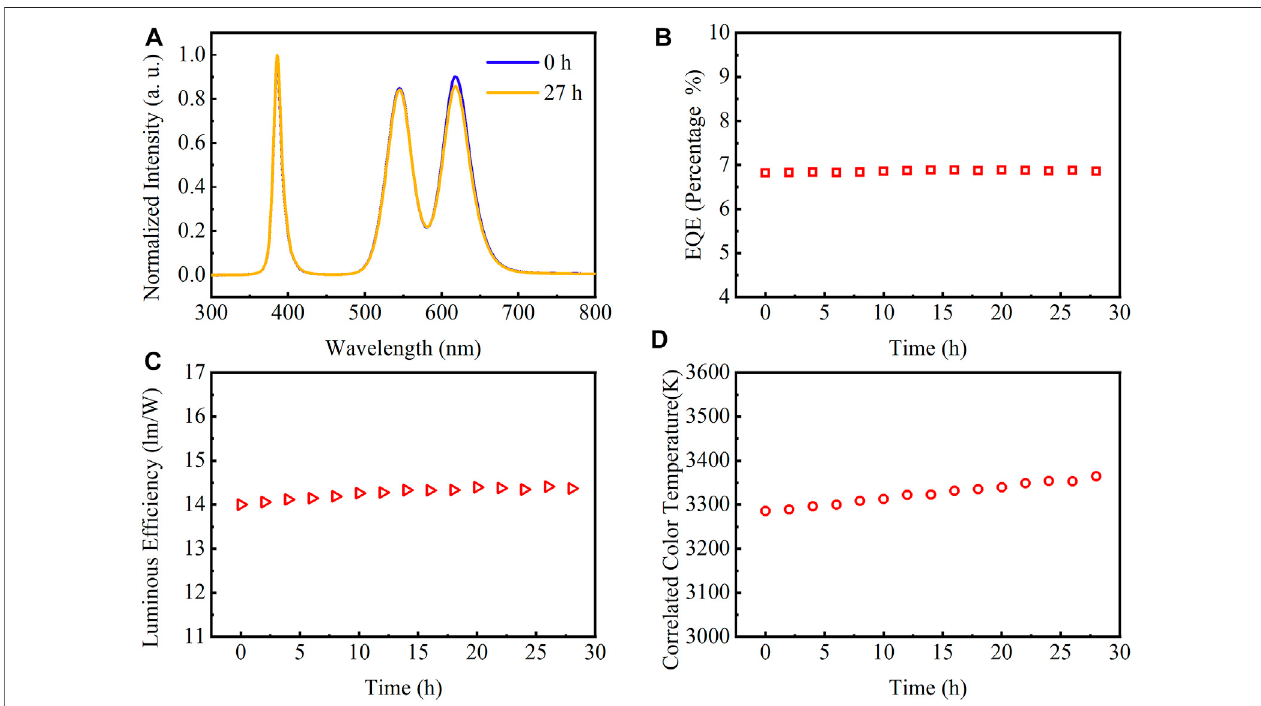
FIGURE6|(A) EmissionspectraofQDWLEDatthestartoflightemissionandafter27 h, (B) EQE, (C) LE,and (D) CCTofQDWLEDatdifferenttimeintervalsat3- V voltage. QD, quantum dot; WLED, white light-emitting diode; EQE, external quantum ef fi ciency; LE, luminous ef fi ciency; CCT, correlated color temperature.